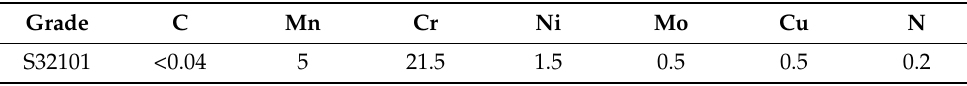
Table 1. The chemical composition of S32101 (wt.%).